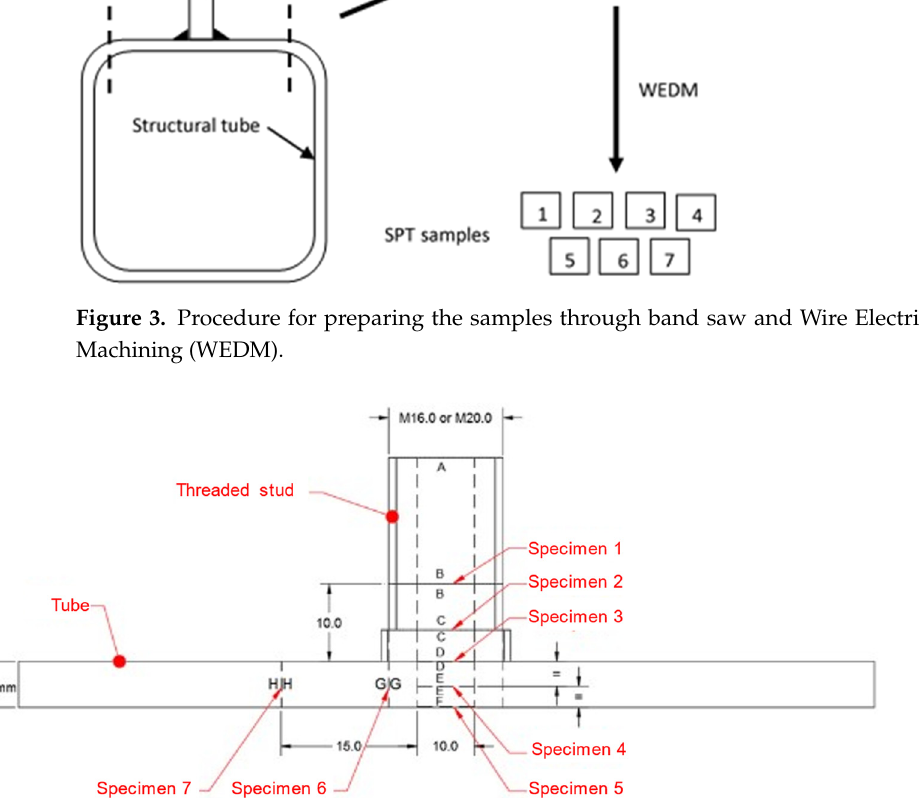
Figure 4. Sketch of the welded stud with the positions of the specimens (distances in mm).